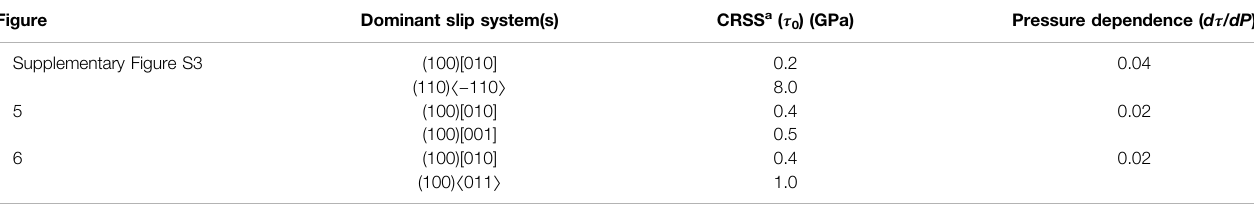
TABLE 2 | Critical Resolved Shear Stresses (CRSS) for the three paired slip models of bridgmanite. Pressure dependence applies only to elasto-viscoplastic self-consistent models. Figure Dominant slip system(s) CRSS a ( τ 0 ) (GPa)